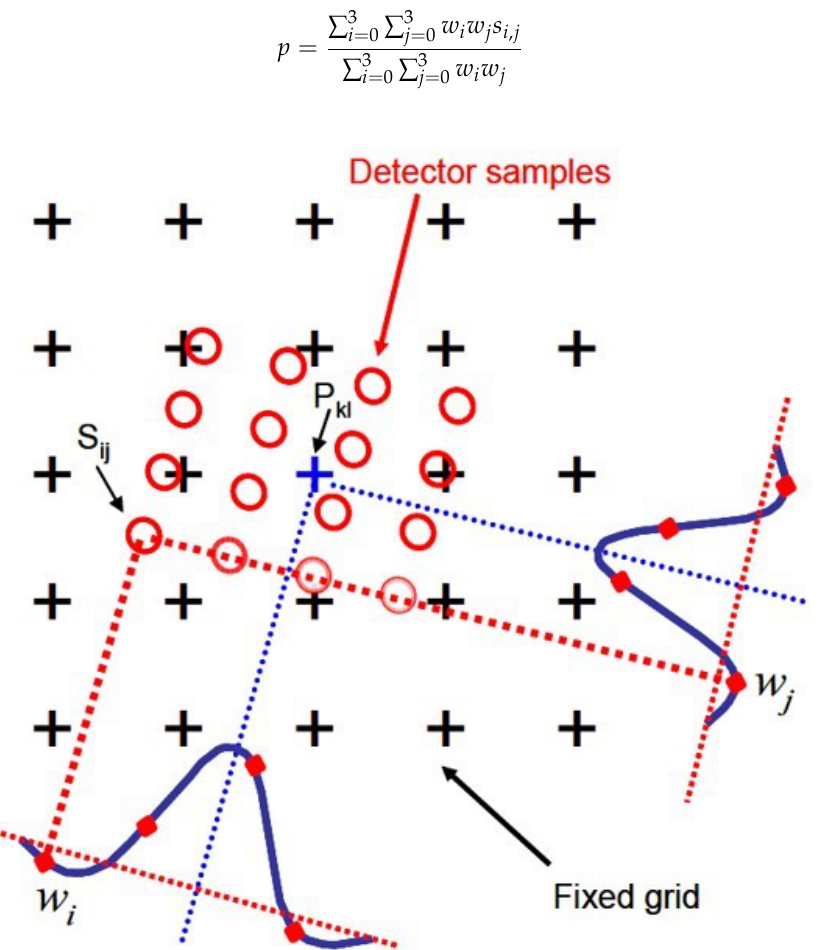
Figure 13. The value for each pixel p is calculated as a weighted average of neighboring detector samples with resampling weights drawn from a resampling kernel